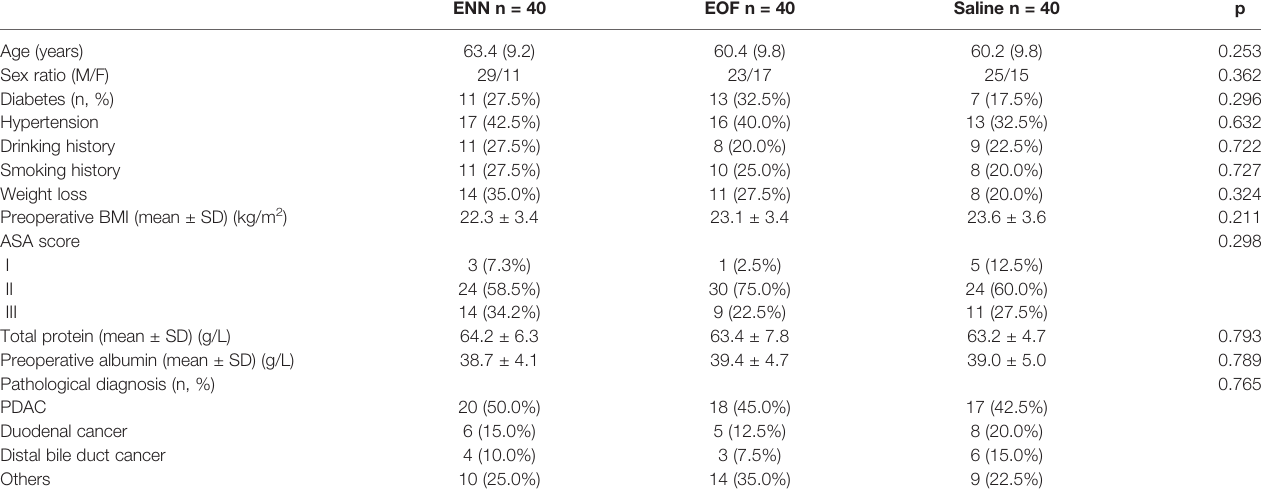
TABLE 1 | Demographic and preoperative data.